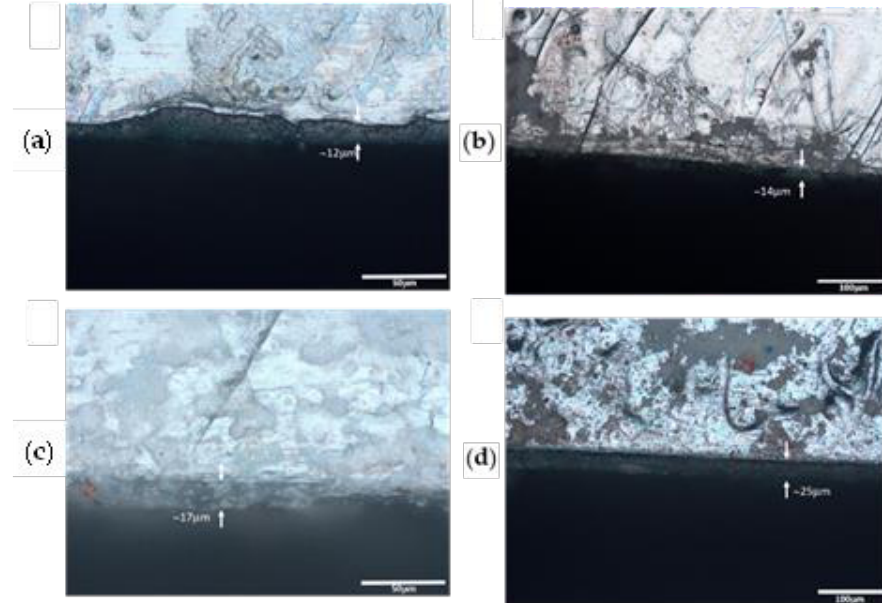
Figure 8. Average coating thicknesses for Ref ( a ), S1 ( b ), S2 ( c ) and S3 ( d ), respectively. Table 3. Roughness parameters of different samples.